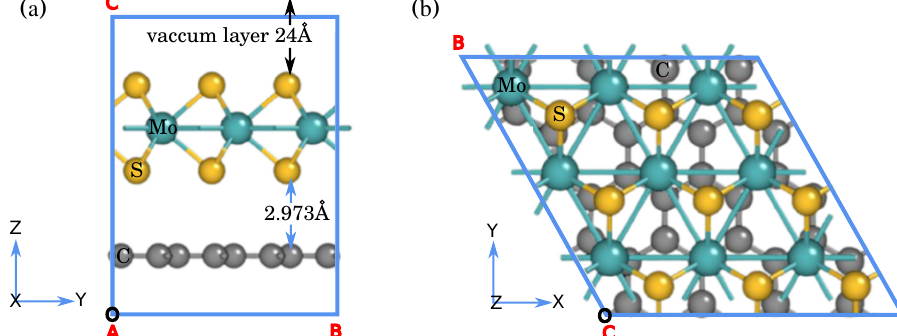
Figure 1. The stacking of the 3 × 3 MoS 2 supercell and the 4 × 4 Gr supercell. ( a ) The side view. ( b ) The top view. For the other MX 2 /Gr, the atom–atom distances are listed in Table